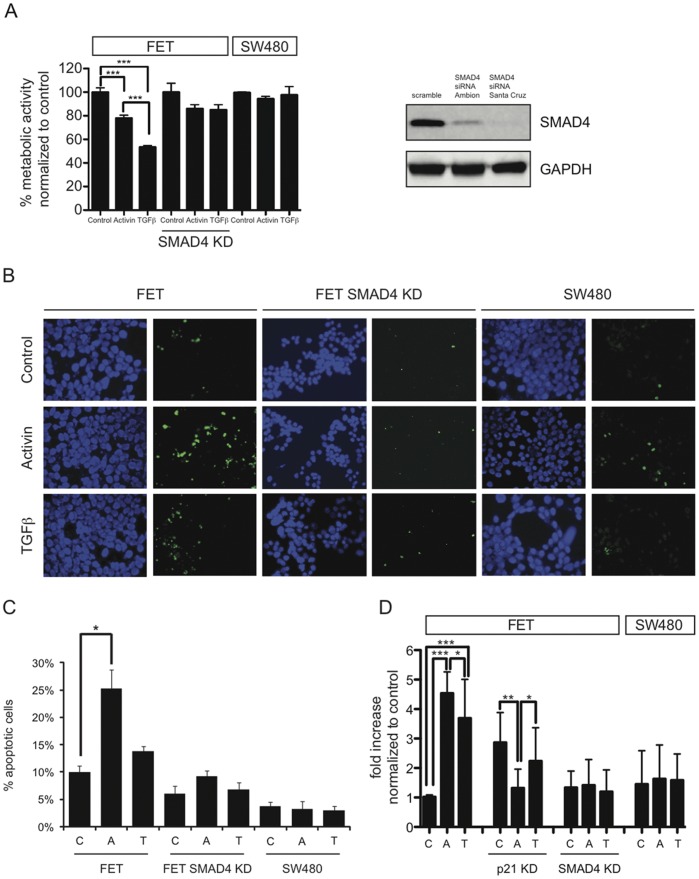
In the presence of SMAD4, TGFβ is a more potent inducer of growth suppression and activin a more potent inducer of apoptosis.A) After ACVR2/TGFBR2/SMAD4-wild type FET, FET cells following transient SMAD4 knockdown, and ACVR2/TGFBR2-wild type/SMAD4-null SW480 cells were treated with vehicle (control), activin or TGFβ for 24 hours, the metabolic activity via MTT-growth assay was assessed. Growth suppression occurred only in the presence of SMAD4 following both activin and TGFβ treatment (***p<0.001). Further, TGFβ led to a significant increase in growth suppression compared to activin (***p<0.001). B) To determine the rate of apoptosis, a TUNEL assay was performed in SMAD4-wild type FET, SMAD4-KD FET, and SMAD4-null SW480 cells treated with control vehicle (C), activin (A), or TGFβ(T). Apoptosis was determined by TUNEL-labeling of apoptotic bodies. C) Normalization [% apoptotic bodies/nuclei] revealed that activin- and TGFβ-induced apoptosis occurred predominantly in SMAD4-wild type FET and not in SMAD4-KD FET or SMAD4-null SW480 colon cancer cells. In the SMAD4 expressing cells, activin induced apoptosis to a greater degree than TGFβ (*p<0.05). D) BrdU-labeled intracellular DNA fragments, indicative of apoptosis, were determined 24 hour after activin or TGFβ treatment of SMAD4-wild type FET colon cancer cells, FET cells with p21 KD, FET cells with SMAD4 KD and SMAD4-null SW480 colon cancer cells. Increase in DNA fragmentation was noted after activin and TGFβ treatment only in the SMAD4 wild type cells, with activin inducing more fragmentation compared to TGFβ. In the presence of SMAD4, p21KD lead to a basal increase in apoptosis, but activin treatment lead to no induction of apoptosis. SMAD4 knockdown resulted in loss of apoptosis in FET cells akin to effects observed in the SMAD4-null SW480 cells (*p<0.05, **p<0.01, ***p<0.001).